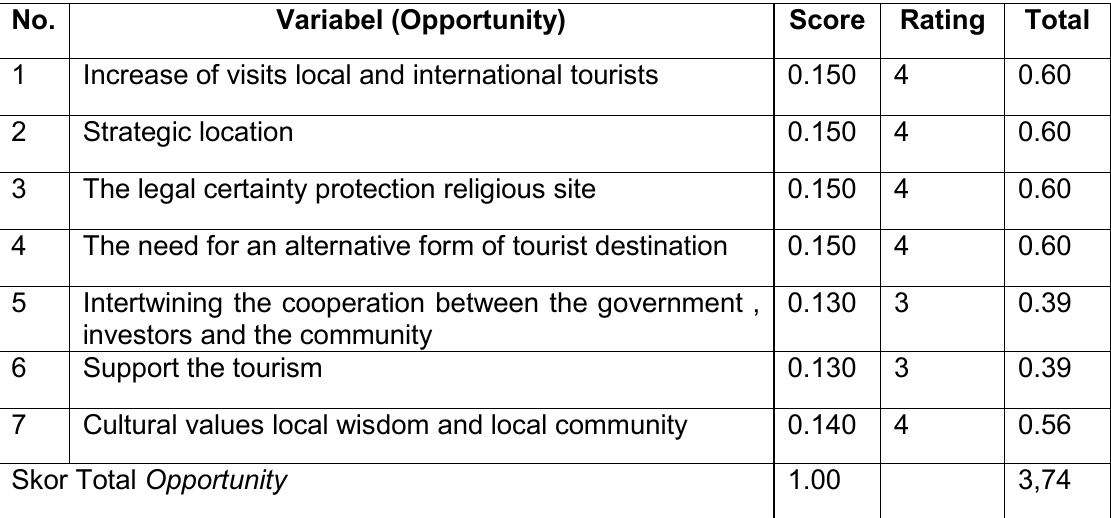
Table 3. External Strategic Factor Analysis Summary (EFAS) Opportunity